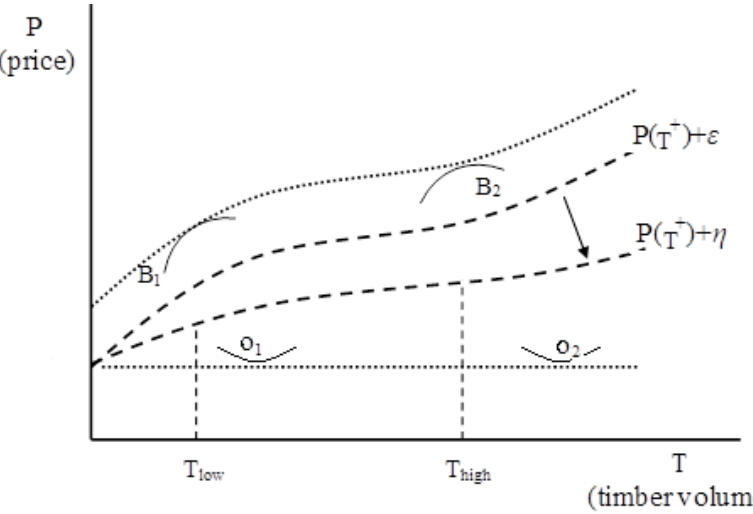
Figure 1. Hedonic prices with asymmetric information when sellers are better informed. Source: own elaboration based on Pope’s model [19,22].